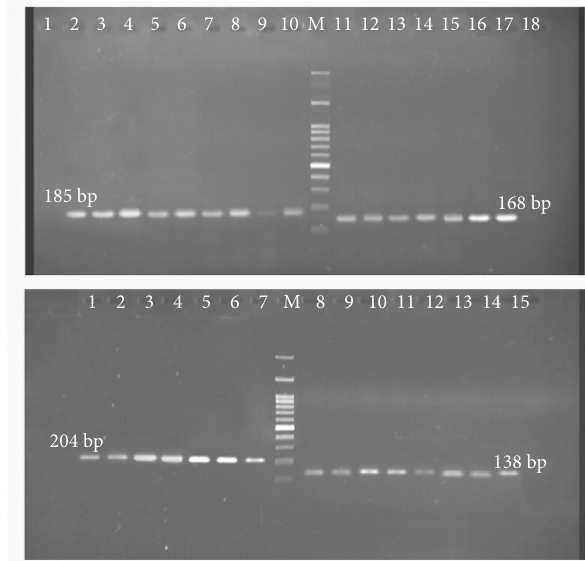
Figure 3: The amplification and gel electrophoresis agarose of 1.5% of bla OXA genes in P. aeruginosa . Top: bla OXA-539 with 185bp and bla OXA-224 with 168bp; wells 1 and 17: positive control, well 18: negative control, wells 3–9: positive strains with bla OXA-539; wells 11–18: positive strains with bla OXA-224. Down: bla OXA-145 with 204bp and bla OXA-675 with 138bp; wells 1 and 14: positive control, well 15: negative control wells 2–7: positive strains with bla OXA-145, wells 8–14: positive strains with bla OXA-145. M: ladder